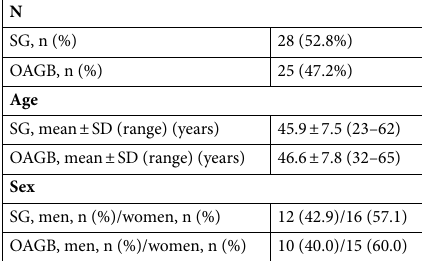
Table 1. Obese T2DM patient characteristics. T2DM type 2 diabetes mellitus, SG sleeve gastrectomy, OAGB one anastomosis gastric bypass, SD standard